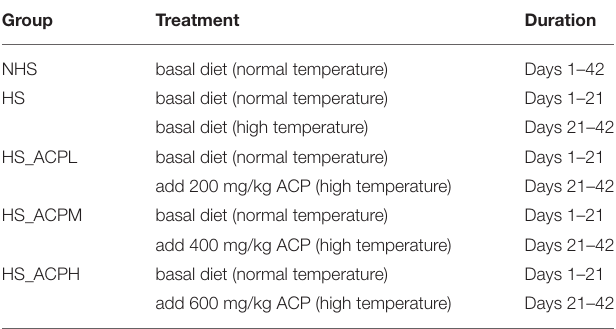
TABLE 1 | Different treatment groups in